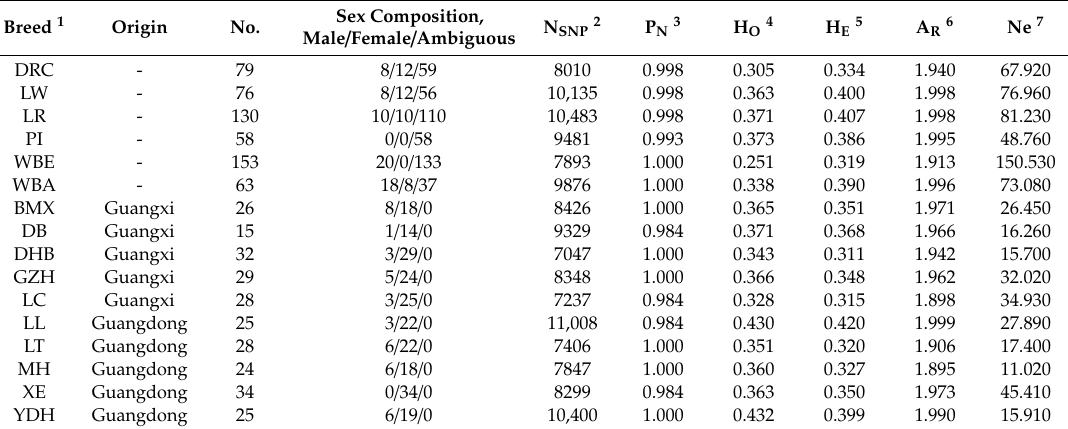
Table 1. Sample size and genetic diversity of each breed 1